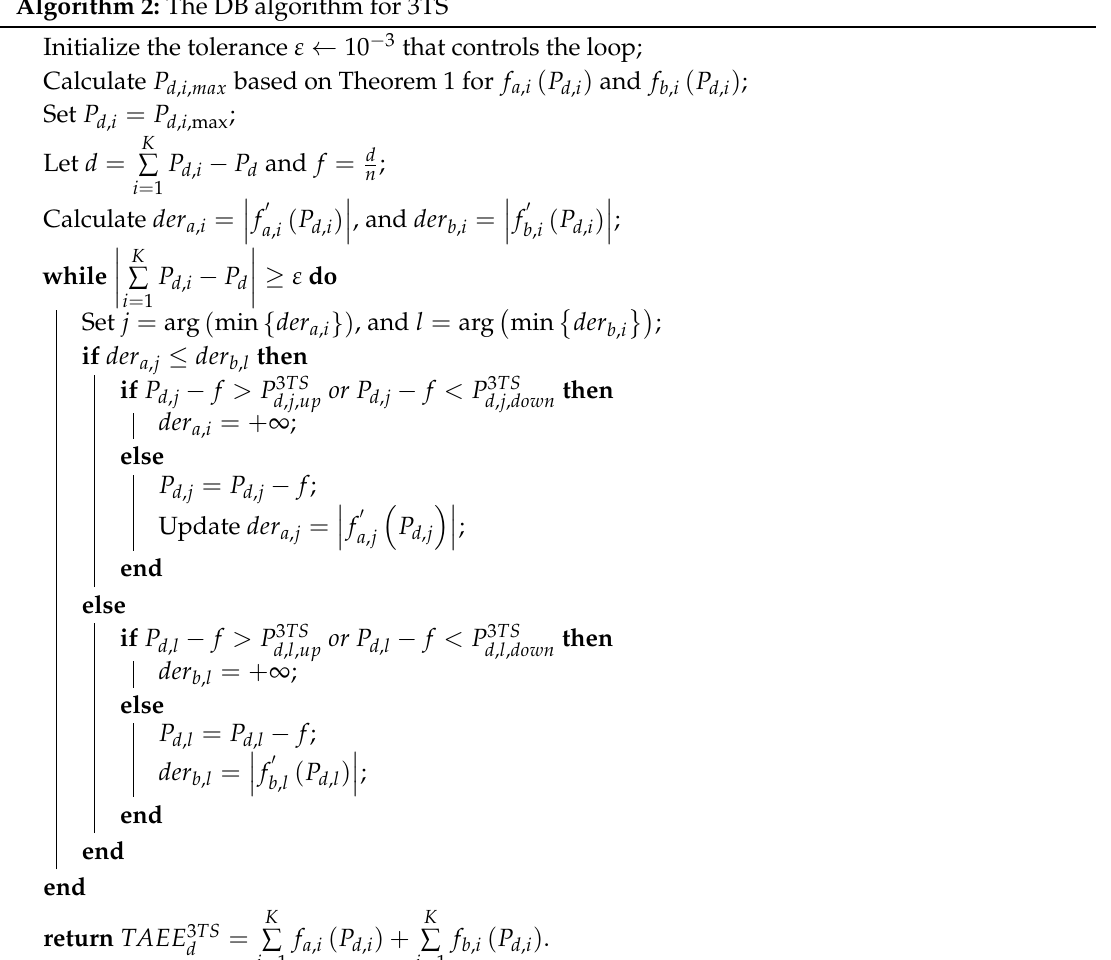
Algorithm 2: The DB algorithm for